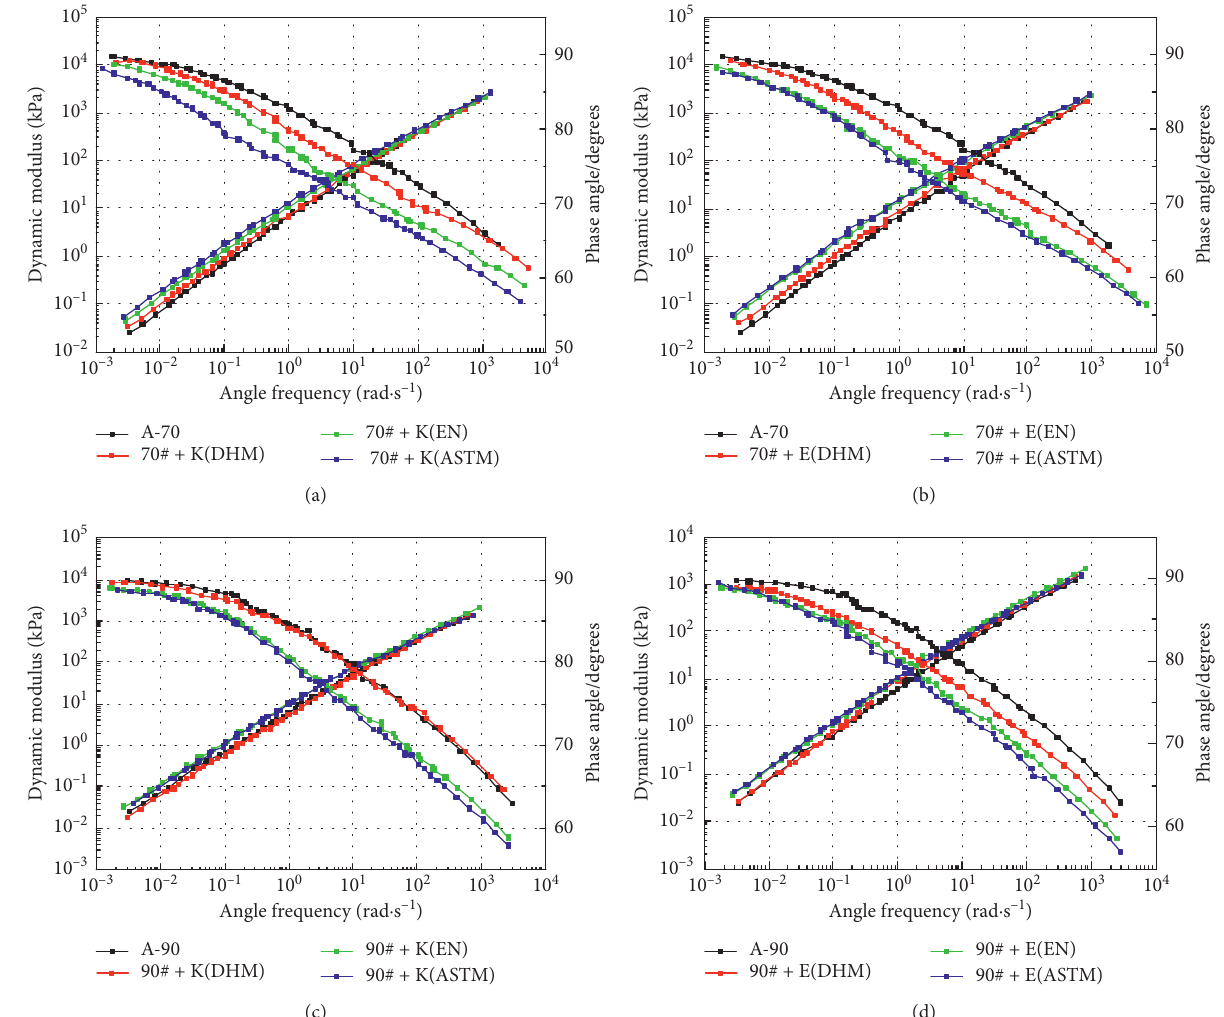
Figure 6: Master curves of emulsified asphalt residues at a reference temperature of 40 °